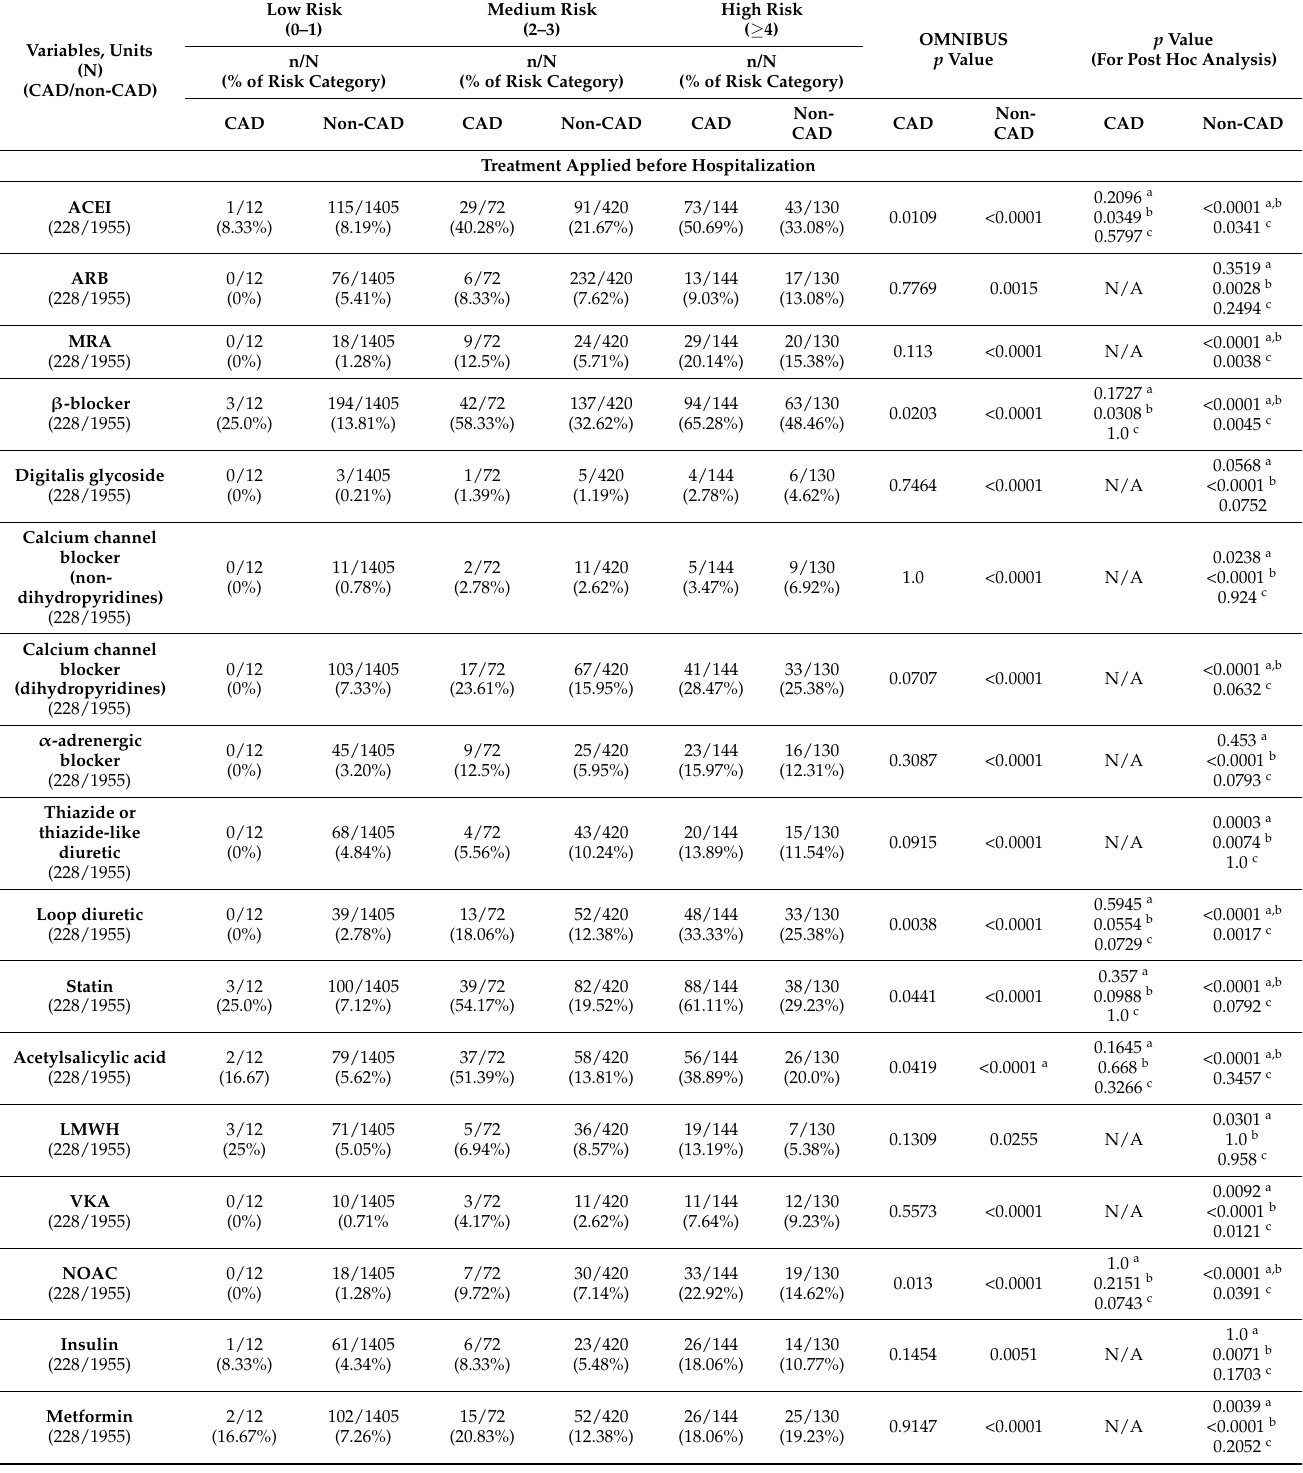
Table 2. Baseline characteristics of the study cohort—treatment applied before